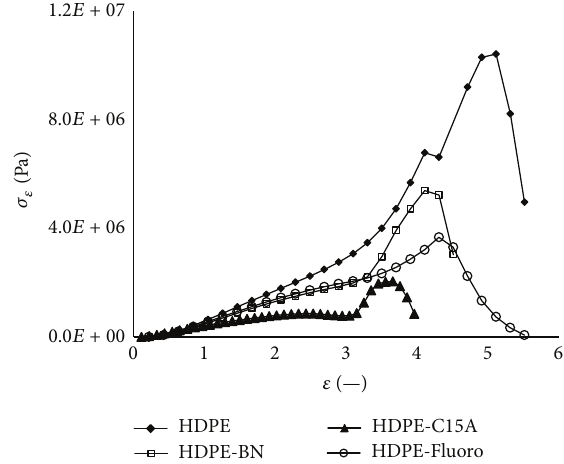
Figure 6: Extensional stress growth versus extensional strain for HDPE, HDPE-C15A, HDPE-BN, and HDPE-Fluoro.